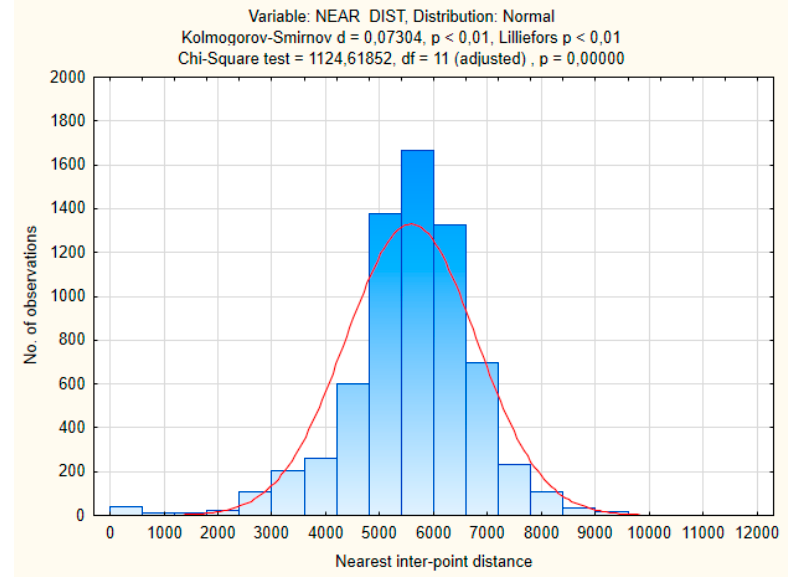
Figure 6. Histogram of nearest inter-BGCPs distance.